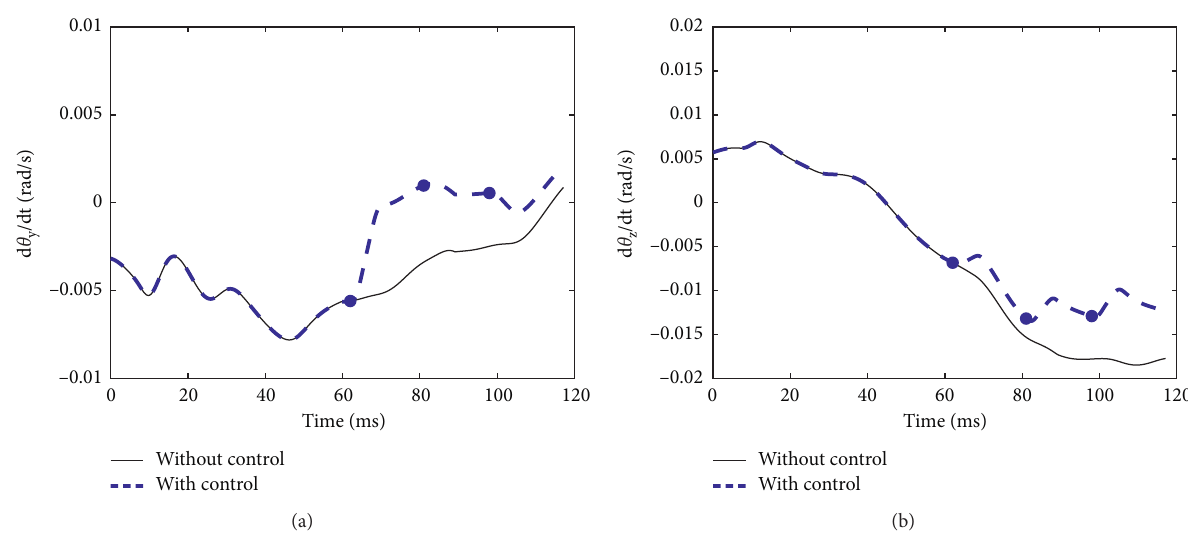
Figure 7: Simulated results of the elevation part in launching process for the 2nd rocket under Condition 1: (a) the yawing angular velocity and (b) the pitching angular velocity. The blue dots indicate the action of the